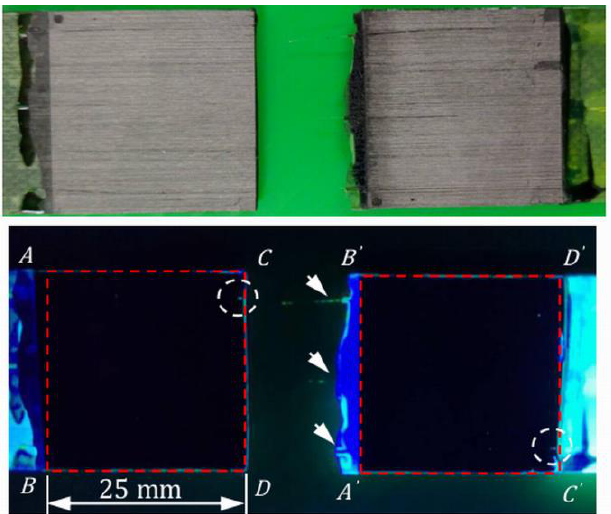
Figure 8. Fractured adhesive joint observed under visible light ( top ) and UV light ( bottom ) after fluorescent penetrant treatment.